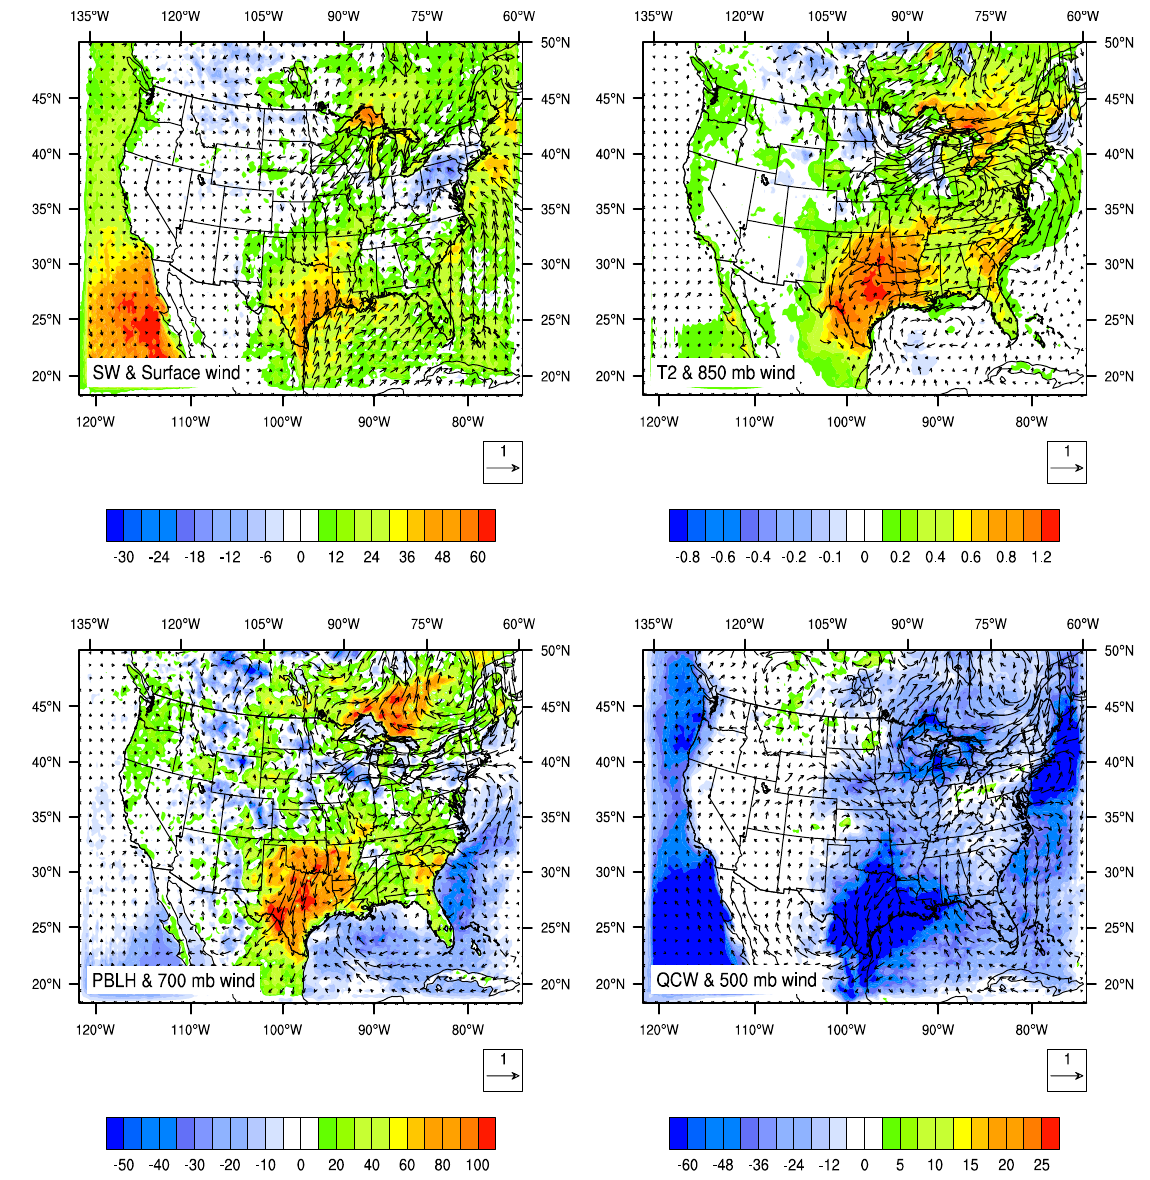
Figure 6. Same as Figure 4 except for changes due to